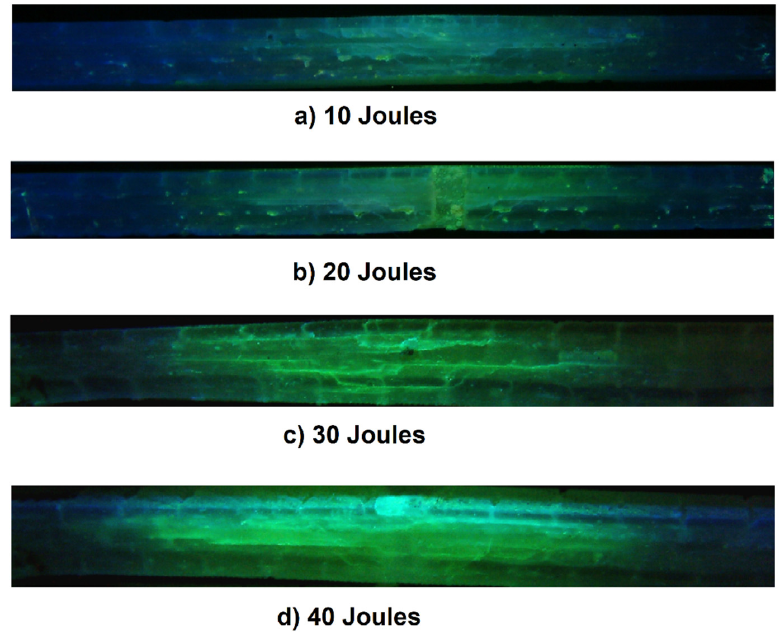
Figure 10. Characterization with ultraviolet light to the sections of the laminates in the impact zone, ( a ) 10 joules, ( b ) 20 joules, ( c ) 30 joules and ( d ) 40 joules. To evaluate the failures in the matrix, the cut sections were observed with an increase of ×150 as observed in Figure 11a. There is porosity in the circular shaped matrix which indicates that gases were trapped during the curing process. The quantity of pores evalu- ated qualitatively is not very significant, but it does influence the results. In Figure 11 it is observed that the rupture of the matrix is around two larger pores in relation to the others exposed in the image. The penetrating ink has painted the surrounding area allowing con- centration and stresses and damaging the matrix. There are also areas with pores in which there has been no damage to the matrix. The different shades of the green color of the fluorescent penetrating ink is an indicator of the magnitude of the damage, because the more accentuated the green color, the greater the damage in the laminate layer. It could not be identified by the type of increase which is the layer that corresponds to this damage, but it is estimated that it is between number 2 and number 3 of the first prepreg fabric composed of three warps. Figure 11b shows a delamination identified by the color of the fluorescent penetrating ink for an impact at 20 Joules magnified ×150. There are several pores on the delamination zone, but these do not influence the laminate damage. The ul- traviolet light shows that the ink has penetrated between the layers, indicating a cohesion failure caused by the impact. No cracks in the matrix or microcracks are observed. This section shown corresponds to layers 1 and 2 of the first warp. It should be noted that in Figure 11b an entire area shaded with fluorescent ink is observed, and from the image obtained at ×150 zoom is ruled out that it is a surface with a large number of microcracks since it is clean of damage and the defects or porosities have not affected the matrix core or produced any damage.